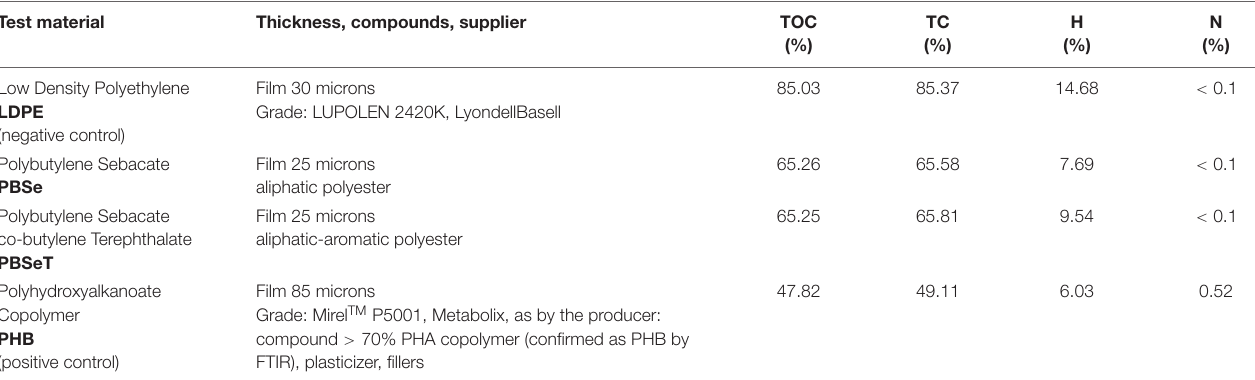
TABLE 1 | List of tested polymers with their properties, film thickness, compounds, and supplier. Percentage of total organic carbon (TOC), total carbon (TC), hydrogen (H), and nitrogen (N) analyzed with standard methods. Test